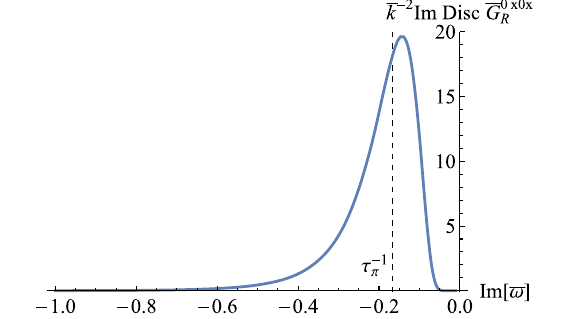
Fig. 12 The suitably normalized imaginary part of the discontinuity ( ¯ k + Im ( ¯ ω), ¯ k )/ k 2 | ¯ Im Disc ¯ G 0 x , 0 x as a function of Im ¯ ω along the k = 0 R cut at Re ¯ ω = 0